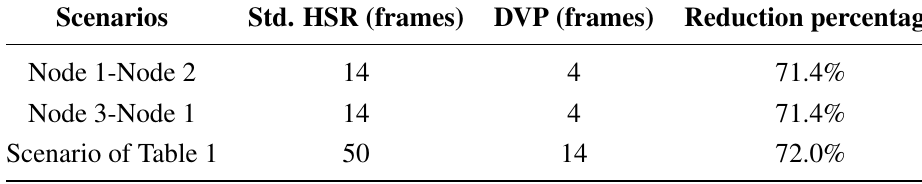
Table 4. Network traffic comparison between the standard HSR protocol and DVP algorithm under the node-failure